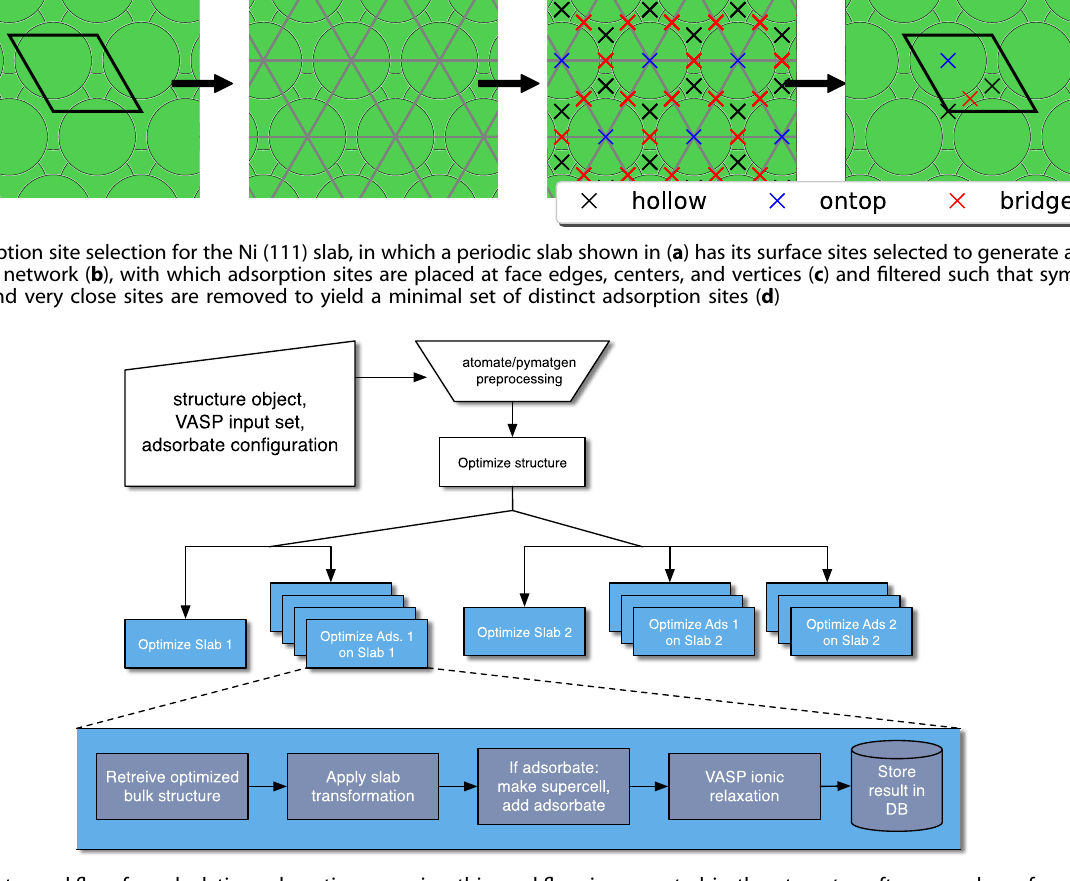
Fig. 4 Atomate work fl ow for calculating adsorption energies: this work fl ow is generated in the atomate software package from structure, VASP parameters, and adsorbate con fi guration inputs. The work fl ow begins with a stress-based structure optimization that branches into ionic relaxation of slab and adsorbate geometries. In each task, the results of the VASP simulation are either stored in a database or output to the fi lesystem in a JSON